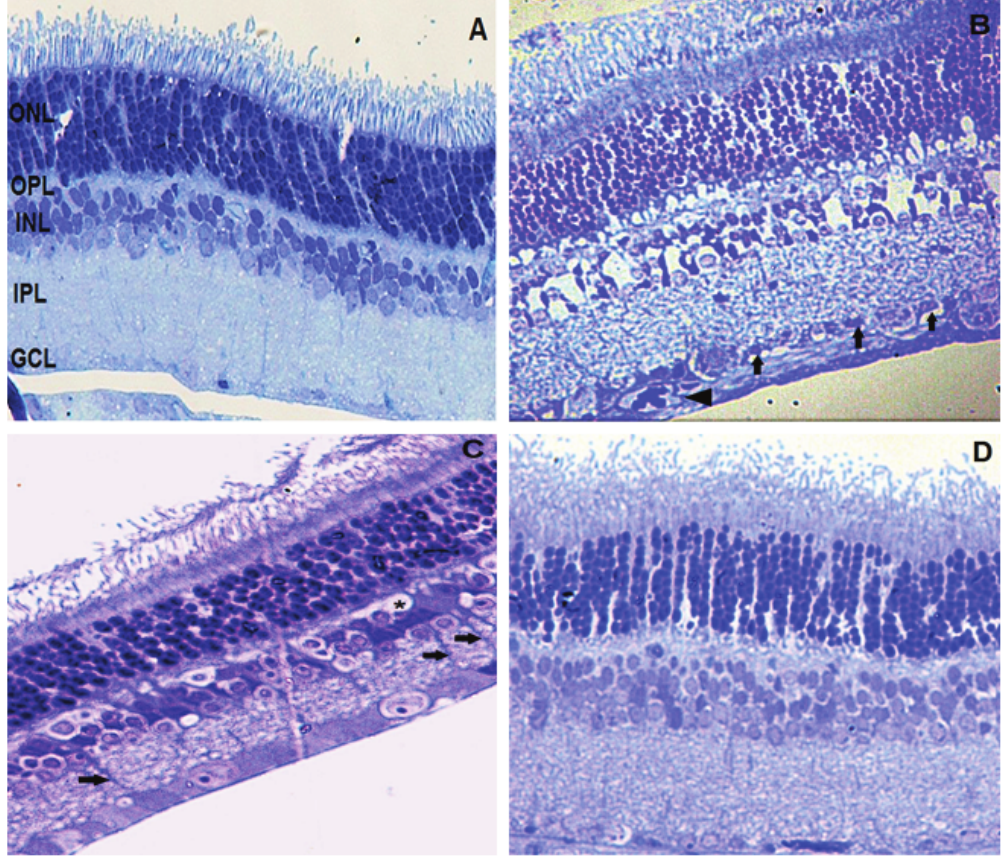
Figure 1. (A) The retinal architecture in groups C and G is organized into regular layers. (B) & (C) The retina in group D showed remarkable cell death in the ONL and INL, severe vacuolation of the IPL and spongiform OPL, heavily stained, shrunken nuclei in the GCL, and hypertrophy of the radial processes of Müller cells (arrows). Arrowhead: A blood vessel projecting via the GCL into the nerve fiber layer; Asterisk: Scattered anucleate ghost cells within the INL. (D) the structure of retinal layers in group DG was more regular and normal. ( × 400 magnification) ONL, outer nuclear layer; INL, inner nuclear layer; IPL, inner plexiform layer; OPL, outer plaxiform layer; GCL, ganglion cell